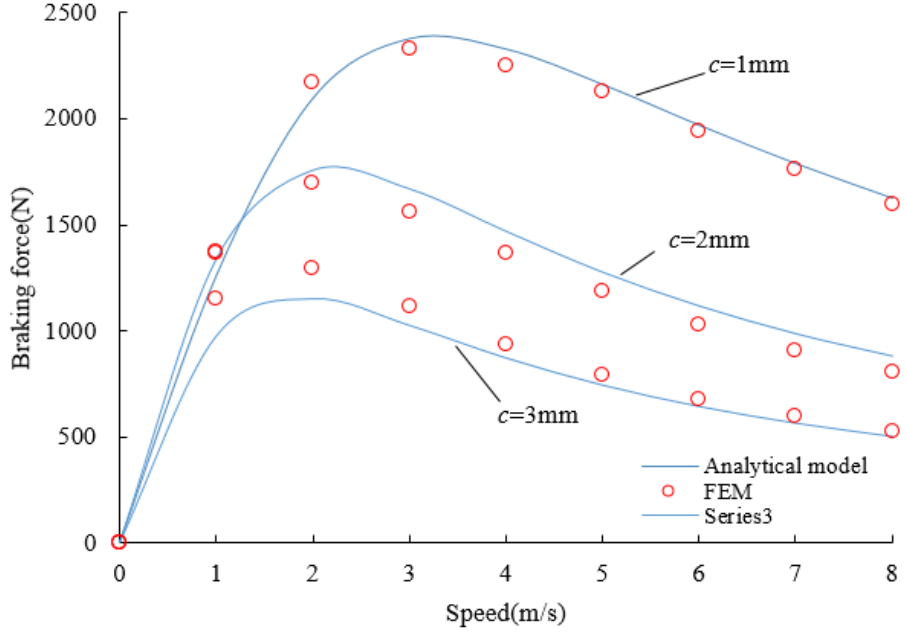
Figure 9. Braking force-speed characteristic for different conductor thicknesses.